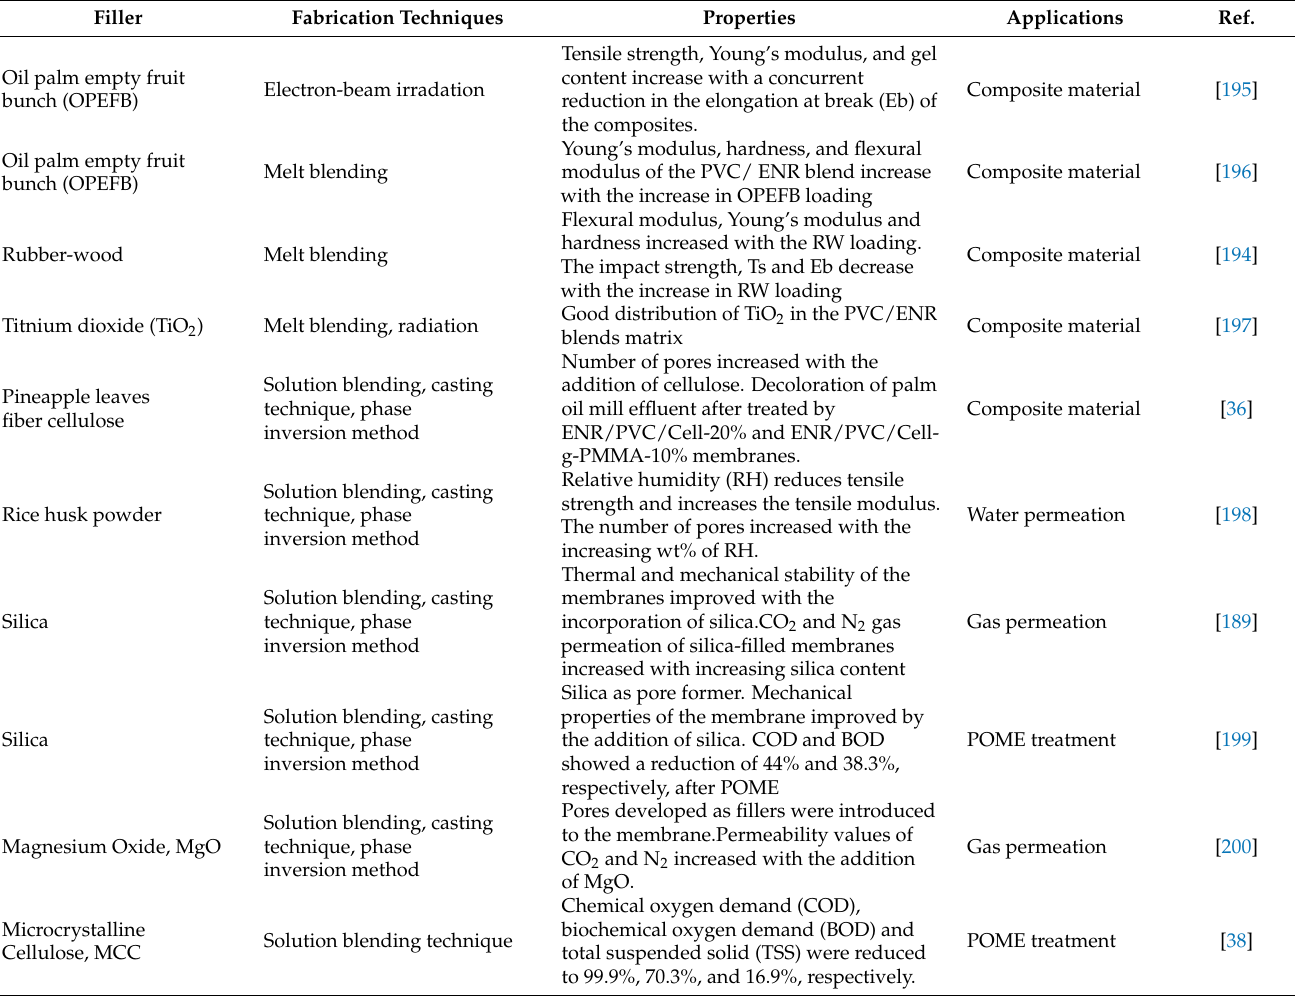
Table 4. Filler for ENR/PVC matrix